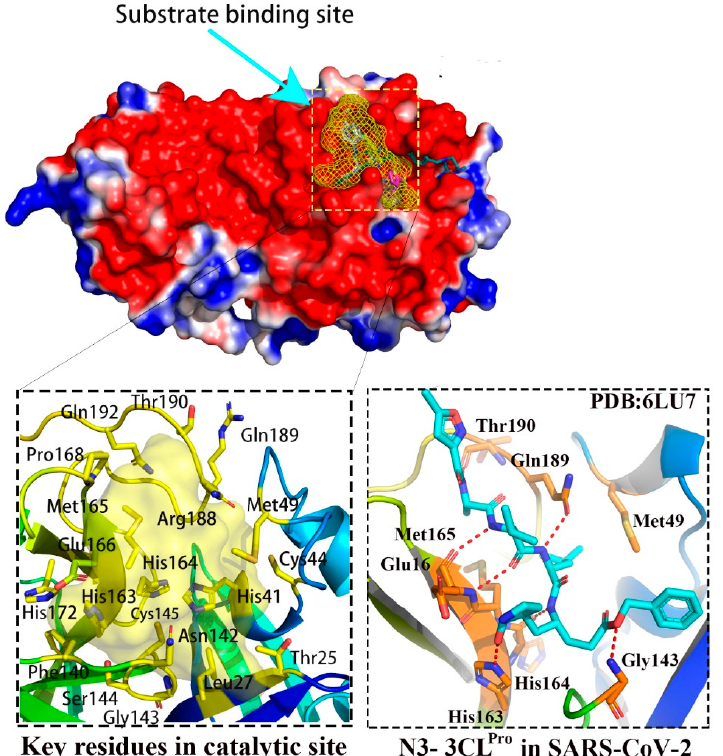
Figure 1. The substrate binding site in M pro structure of SARS-CoV-2. Compared to the substrate-binding site, two allosteric binding sites [16] were re- ported on the opposite surface of M pro structure of SARS-CoV-2, as shown in Figure 2. The first allosteric binding site was highlighted in cyan, which locates between the cata- lytic domains and the dimerization domain. AT7519, a modulator with moderate activity of M pro , is reported to interact with several important residues, including Gln107, Gln110, Asp153, Val202, Ile249, His246, Thr292, Phe294 and more. Specially, Gln110 and Asp153 are observed to form the hydrogen-bond with AT7519, which they may contribute sig- nificantly to the recognition of modulators in this pocket. Moreover, a second allosteric binding pocket highlighted in green is close to the first one, as shown in Figure 2. Four modulators that included ifenprodil, pelitinib, RS-102895 and PD-168568 are observed to bind to the same pocket, in which two allosteric modulators including ifenprodil and pelitinib bind to M pro and show antiviral activity against SARS-CoV-2 [16]. As shown in Figure 2, this allosteric binding pocket is hydrophobic and formed by several residues from the C-terminal dimerization domain, including Ile213, Leu253, Gln256, Val296, Val297, Cys300, Ser301, Gly302 and Val303.